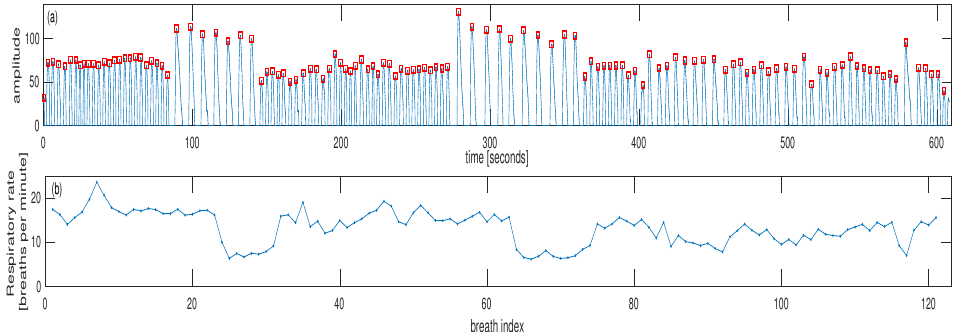
Figure 5. ( a ) The generated signal using thermocouple from subject #1, each pulse is related to one breath. ( b ) Estimated individual breaths using the timing between pulse peaks. There are two episodes of low breathing for this subject. The pulse peaks are noted by red squares in the top plot.